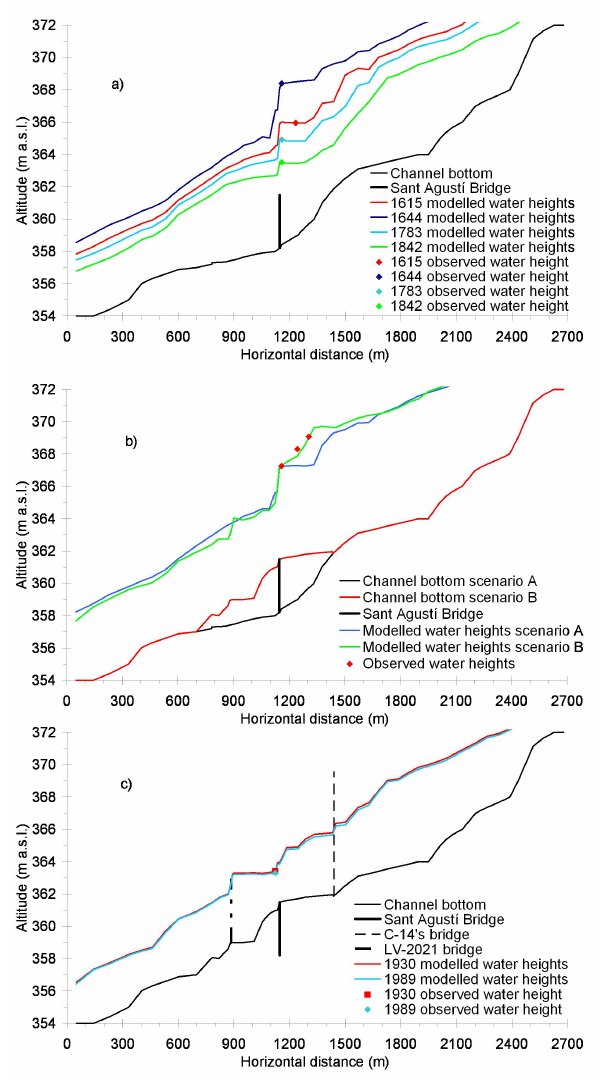
Fig. 8. Modelled and observed maximum water heights of the seven floods: 1615, 1644, 1783 and 1842 floods modelled in sce- nario A (a) ; 1874 flood modelled in both scenario A and B, the latter fitting better the three observations recorded in each of the three limnimarks (b) ; and 1930 and 1989 floods modelled in sce- nario C (c) . (Horizontal axis marks the distance from the junction with the Cercavins